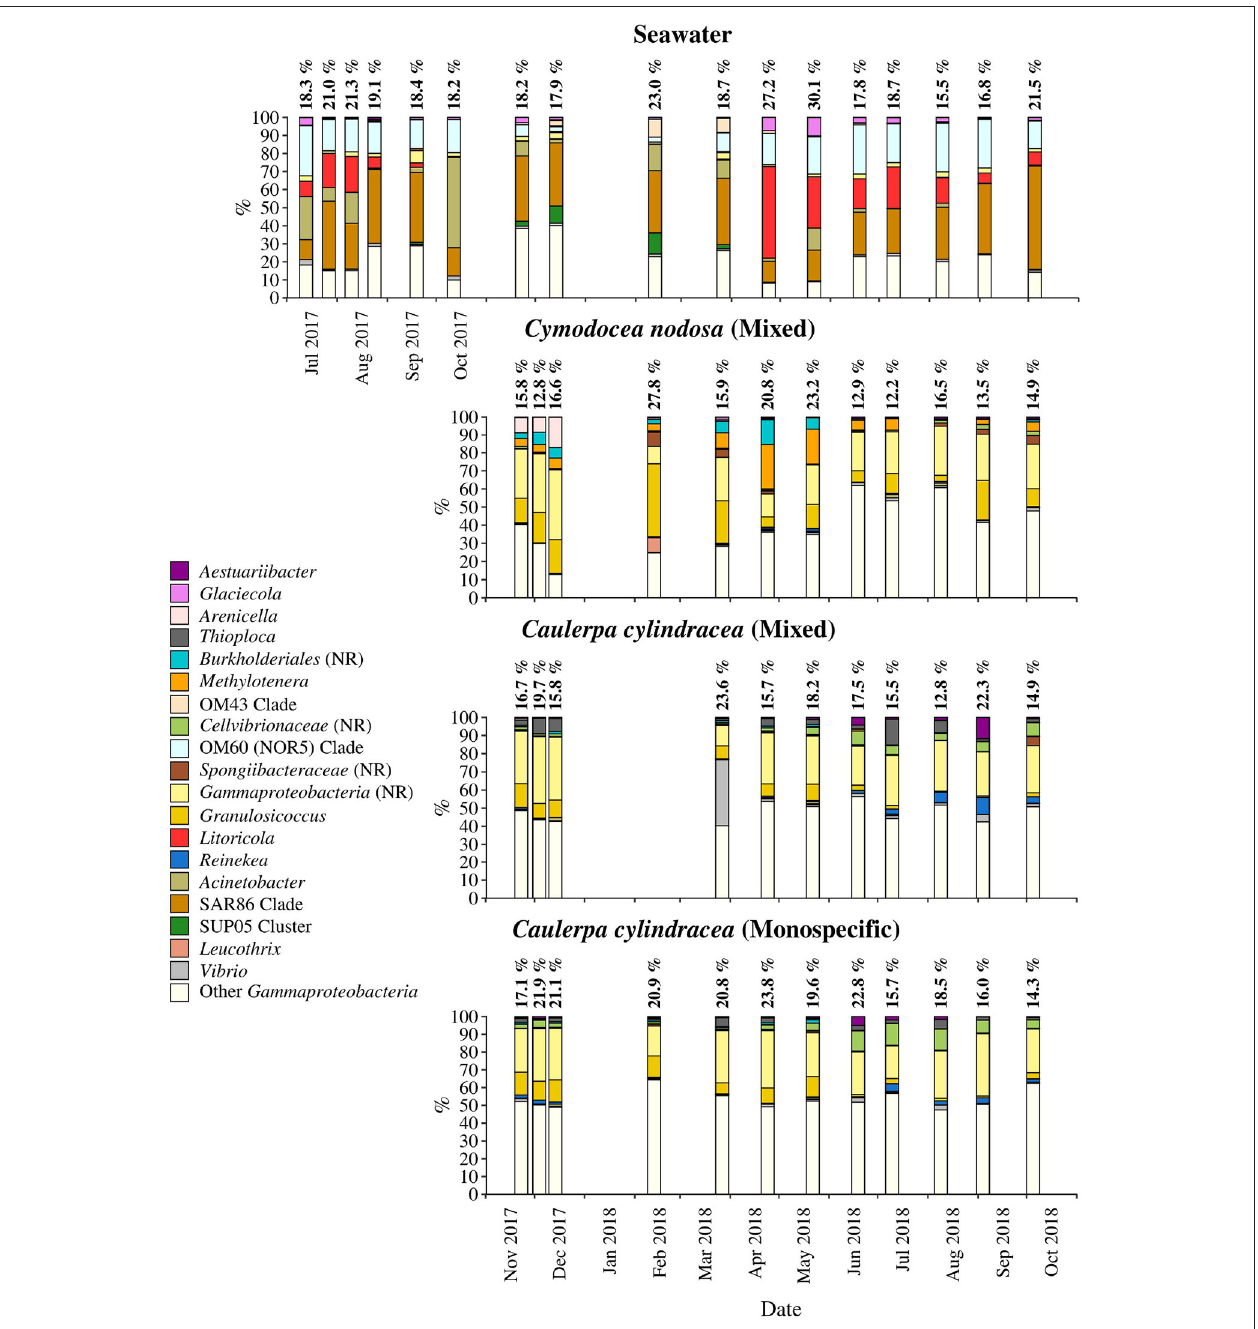
FIGURE 8 | Taxonomic classification and relative contribution of the most abundant ( ≥ 1%) gammaproteobacterial sequences on the surfaces of the macrophytes C. nodosa (mixed settlement) and C. cylindracea (mixed and monospecific settlement) and in the ambient seawater. The proportion of gammaproteobacterial sequences in the total bacterial and archeal community is given above the corresponding bar. NR, no relative (sequences without known relatives within the corresponding group).